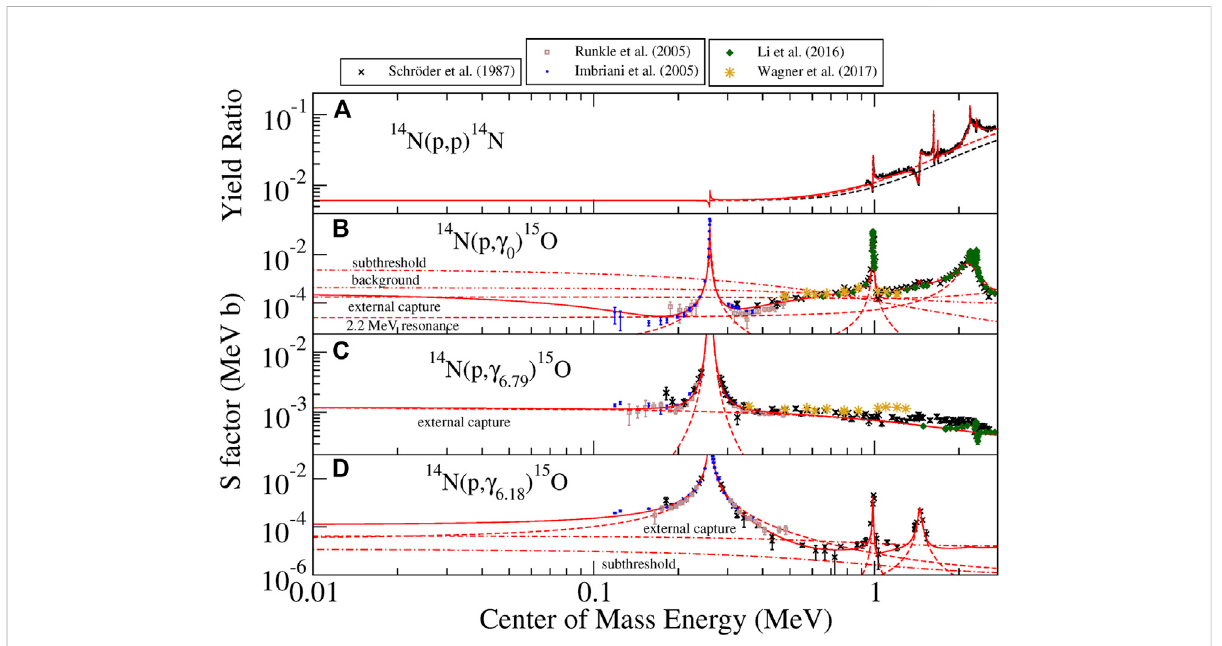
FIGURE 4 Simultaneous R -matrix fi t to (A) the 14 N( p , p ) 14 N data of deBoer et al. [48] and the 14 N( p , γ ) 15 O data of Schröder et al. [49], Runkle et al. [50], Imbriani et al. [43], Li et al. [44], Wagner et al. [51] for the ground state (B) , 6.79 MeV (C) , and 6.18 MeV (D) excited